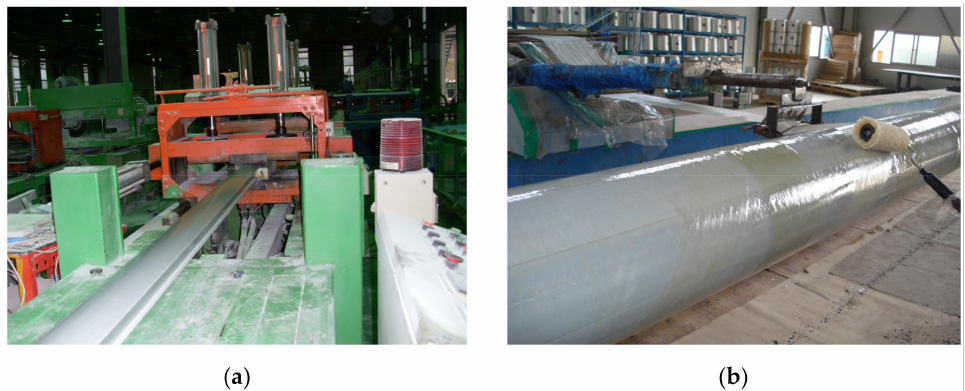
Figure 7. Manufacturing process of the hybrid − FRP member: ( a ) pultrusion process; ( b ) filament winding process.